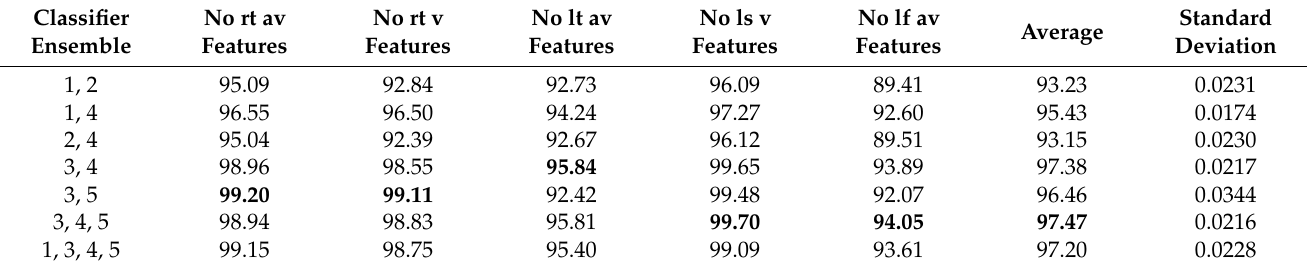
Table 8. The accuracies (%) and standard deviations of the related multiple classifier fusion